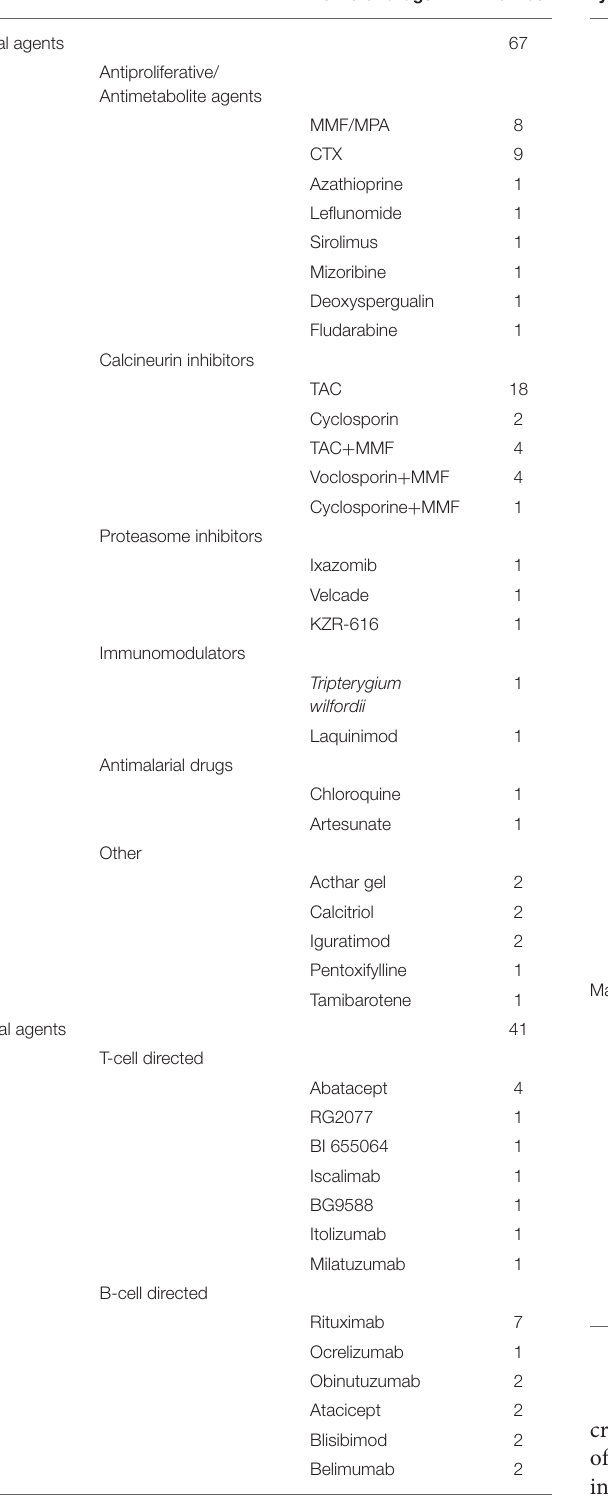
TABLE 1 | Overview of investigated